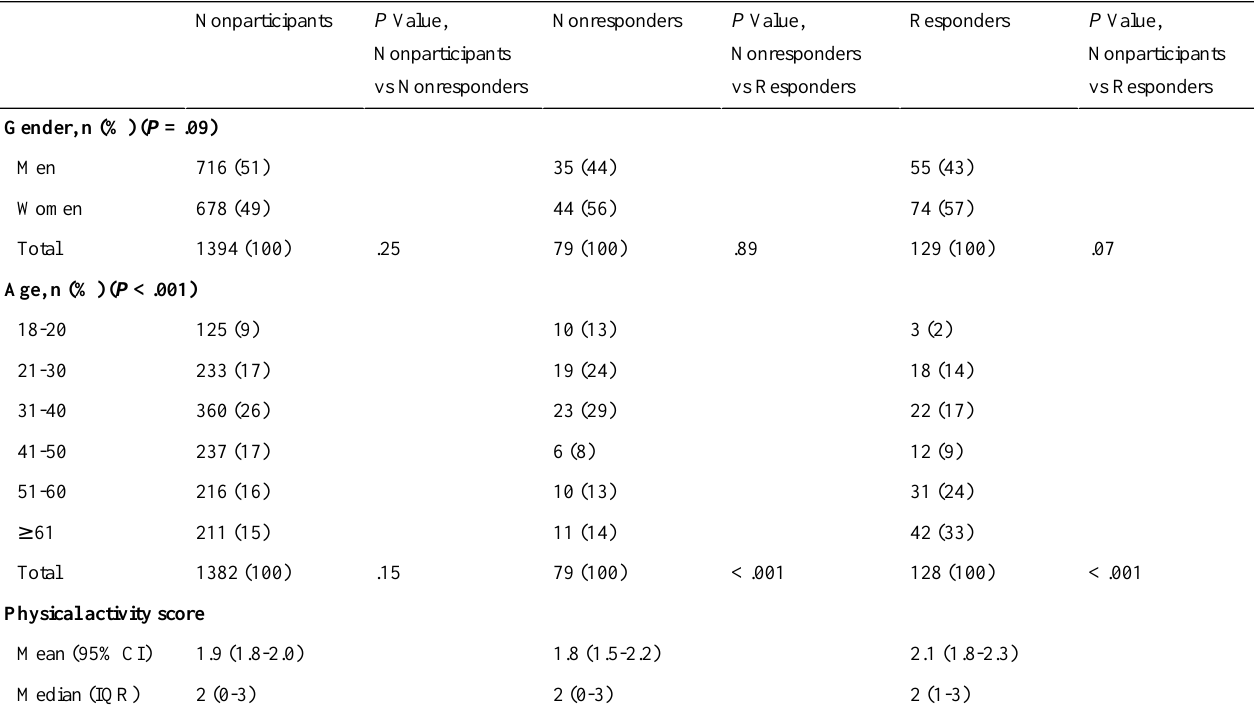
Table 2. Staff-referred e-SBI: baseline characteristics of nonparticipants, nonresponders and responders